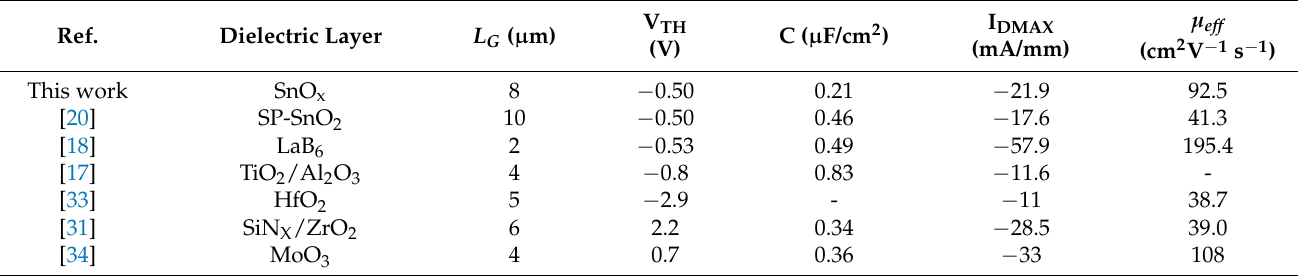
Table 1. Summary of FETs properties with different gate